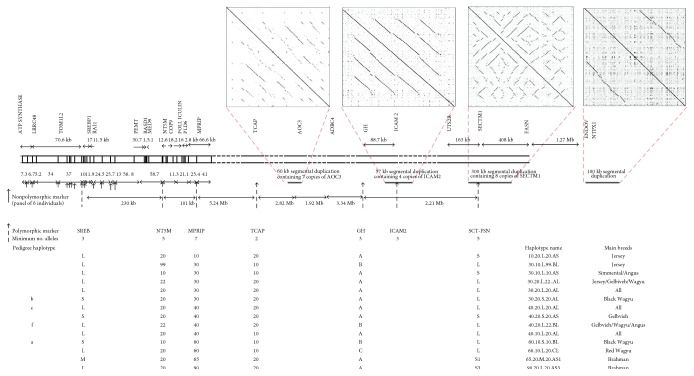
Haplotypes of the marbling region. Polymorphic markers define conserved extended C19 ancestral haplotypes: This region on BTAchr19 is bounded by markers SREBF1 and FASN (see [56] for details). The FASN marker is more correctly known as SCT-FSN since the present marker is adjacent to the coding region for FASN, within the segmental duplication containing SECTM1. The map positions of PCR markers and the number and type of alleles at each locus are indicated including the main high frequency and largely breed-specific haplotypes extending from SREBF1 to TCAP. We have extended the haplotyping through the region and plan to develop more markers based on the potential polymorphism revealed by the structural duplications extending from 43 Mb to 52 Mb (figure and below). Note the regions where PCR product polymorphism was not detected [56]. In structural duplications in C19 35-55 Mb region, we used the current cow genome assembly (Bos_tauros_UMD_3.1.1/bostau8 Assembly) on the UCSC Web Browser and searched the chr19 region from 35 Mb to 55 Mb in 500 kb sectors for large structural segmental duplications using standard dot-plotting methods aligning each 500 kb sector against itself (Gepard 1.30) [63]. We found clusters of rolling, sometimes clustered and inverted, segmental duplications in the reference genome on chr19 at 43.51 Mb (~60 kb in length), 43.86 Mb (~90 kb), 48.86 (~57 kb), and 50.846 Mb (~300 kb). We also found a long single imperfect duplication of 103–112 kb at 52.73 Mb and 52.88 Mb. Some of these dot plots are shown as cutaways in the figure. This region has a relatively low density of protein coding genes.